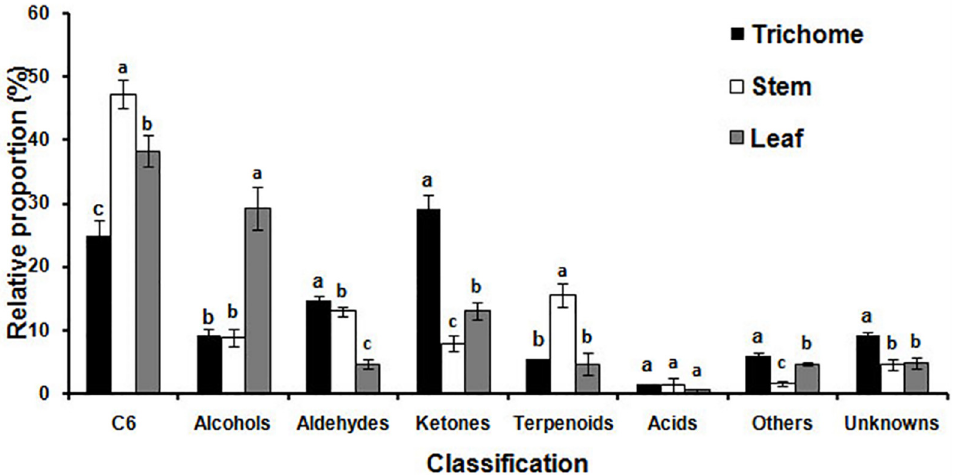
Figure 3. The relative proportion of specific chemical classes of volatile metabolites emitted from glandular trichomes isolated from stems, trichome-free stems, and leaves were significantly different. Vertical bars with the same letter are not significant; however, those indicated with different letters are significant according to the Duncan’s multiple range test ( p < 0.05).